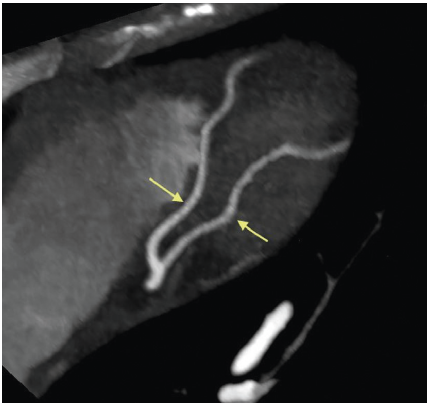
Figure 6: Coronary CTangiogram image revealing the circumflex is nondominant. The proximal segment and obtuse marginal branches are normal.